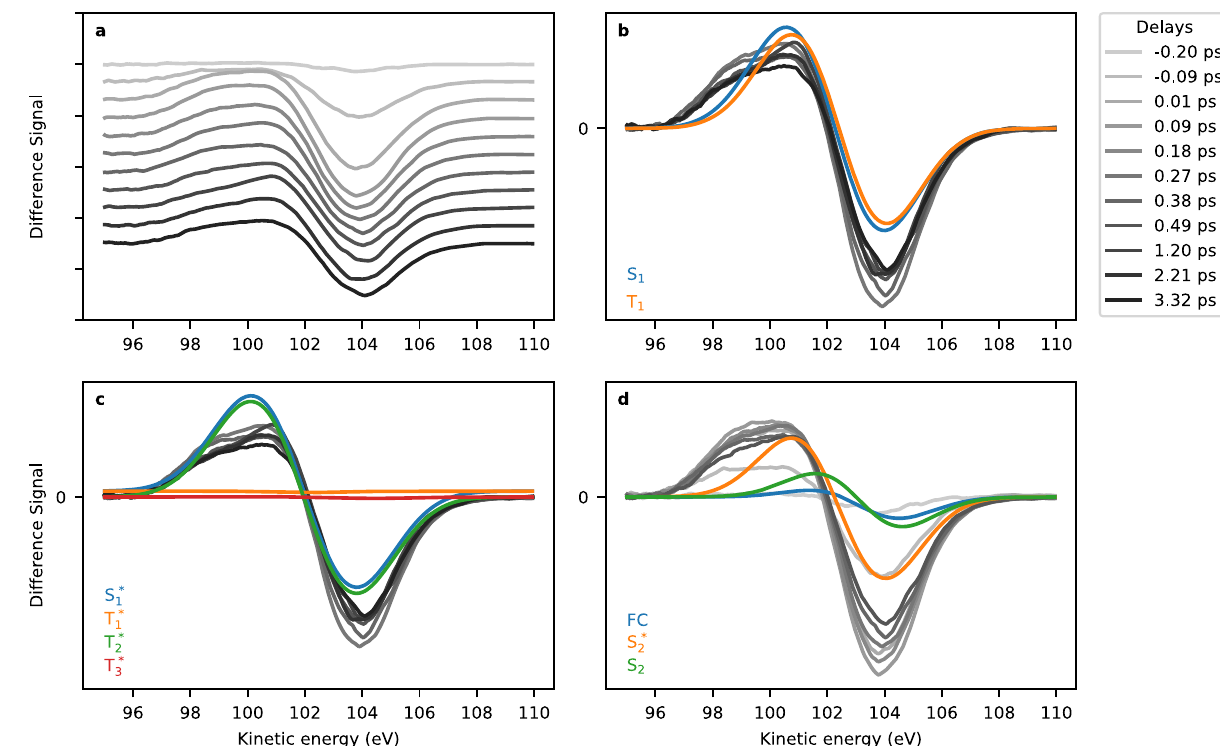
Fig. 5 Comparison between experimental and theoretical difference spectra. a Ridgeline plot of experimental difference spectra for different pump-probe delays between − 0.2 and 3.32 ps. b – d Comparison of experiment (greyscale lines) with theoretical (coloured lines) difference spectra computed at the coupled-cluster level of theory. All calculated difference spectra are shifted lower in kinetic energy by 1.3 eV. b and c Spectra with delays in the range 0.27 – 3.32 ps, ( d ) spectra with delays − 0.2 – 0.49 ps. The theoretical spectra use the energies at the minima (S 2 is the nonplanar, S 2 * is the restricted geometry) and the Franck – Condon geometry. Asterisks denote restriction in the calculation of the states to planar geometries. Source Data are provided as a Source Data fi